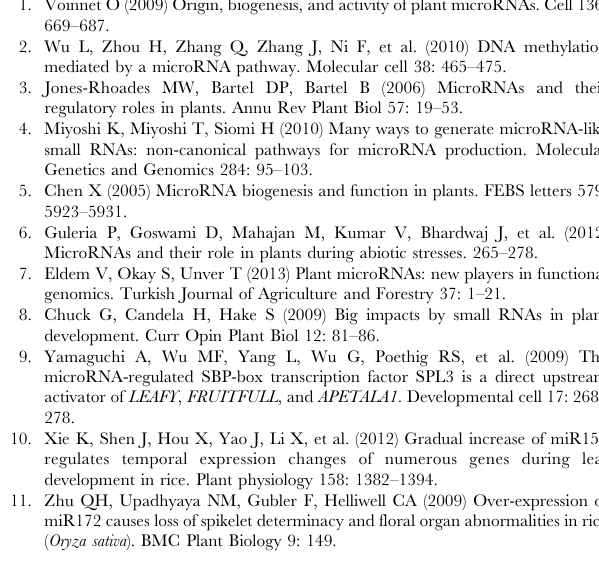
Figure S2 Stem loop hairpin secondary precursor